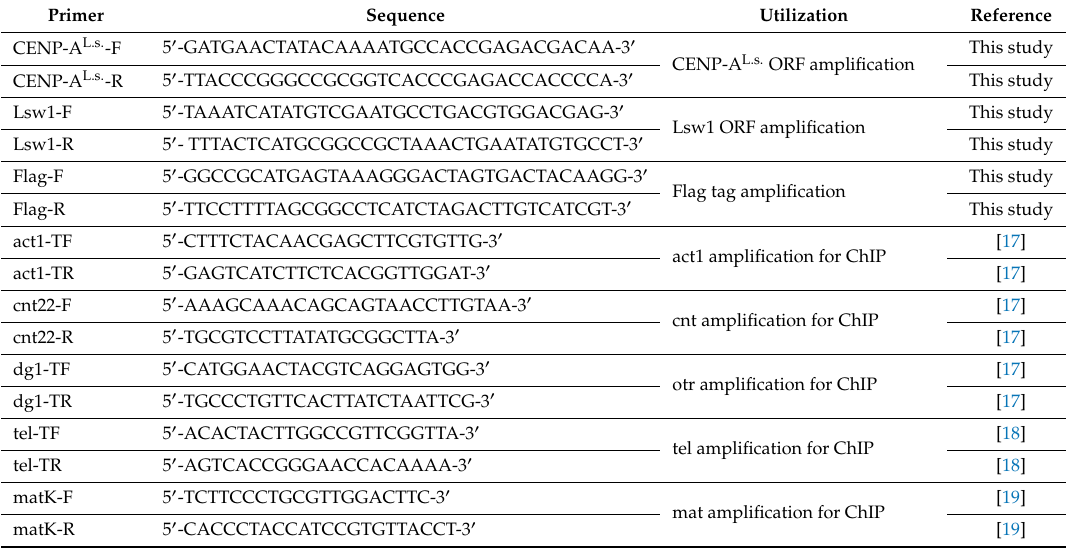
Table 2. Primers used in this